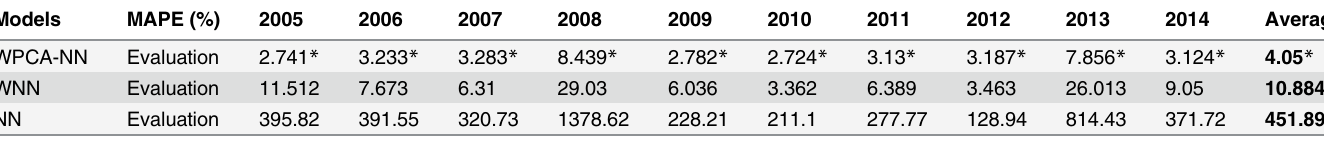
Table 7. Performance of the models, MAPE ratio of evaluation results for NIKKEI 225 futures.